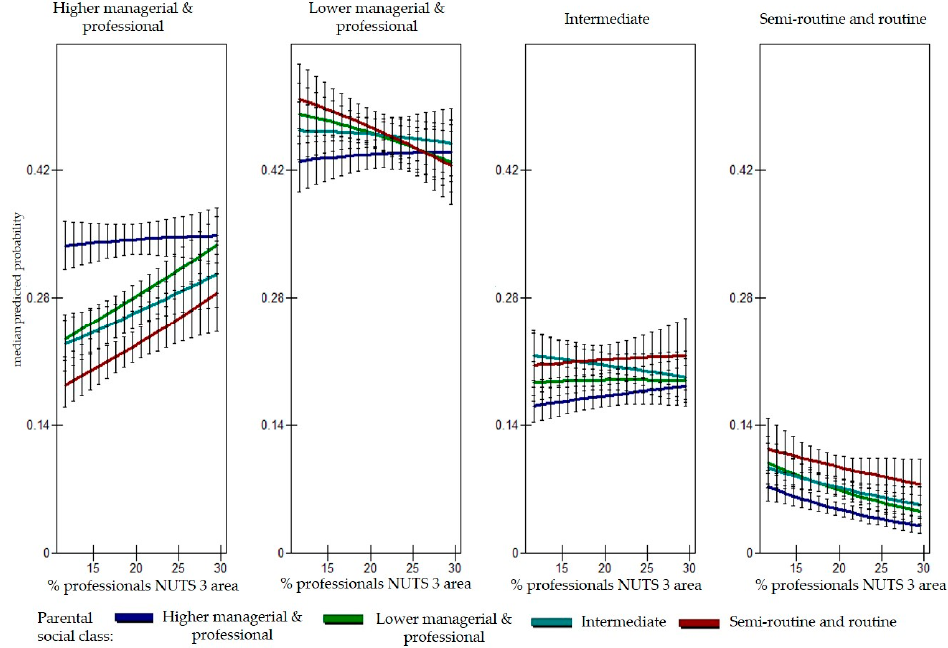
Figure 2. Graduates’ social class by social class of origin and by percentages of professionals in the employment area (NUTS 3). Predicted median probability from a two-way interaction model.